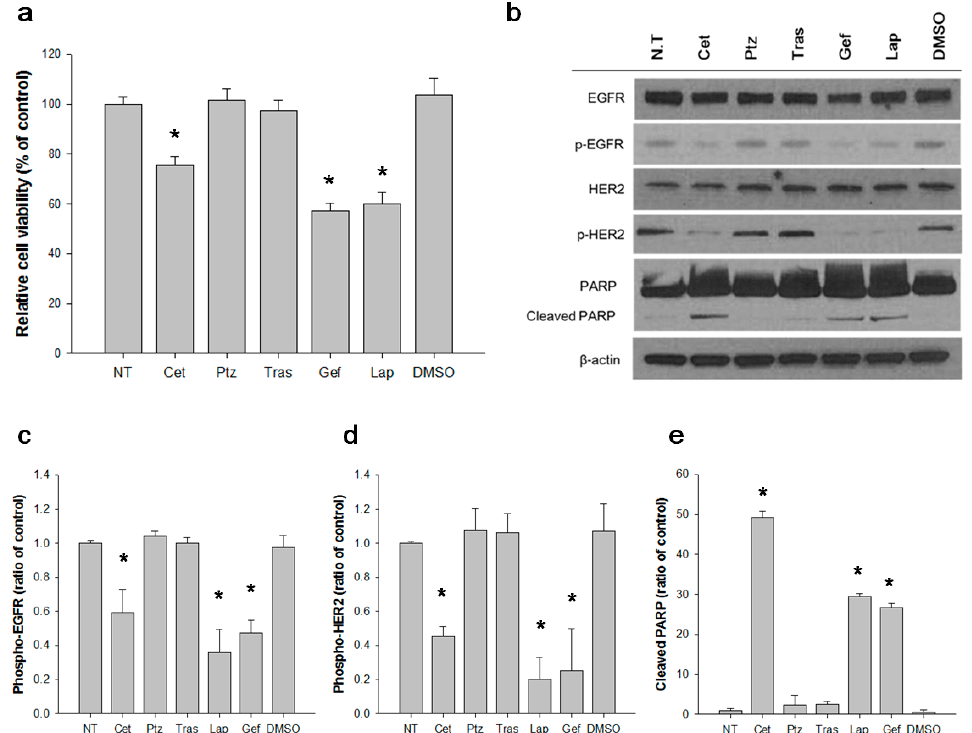
Figure 3. Inhibition of 5637 cell proliferation and receptor activation by anti-HER2 and anti-EGFR agents. Cells were treated with HER2 or EGFR inhibitors for 96 h. ( a ) Cell viability was measured by WST-1 kit as described in materials and methods. Relative cell viability as a percent was determined as ((absorbance in each treatment set—absorbance in untreated set) / absorbance in non-treated set X 100). Results represent the mean ± SD obtained from three independent experiments. * p < 0.05. ( b ) The cell lysate was subjected to immunoblot analysis to visualize the relative phosphorylation level EGFR ( c ) and HER2 ( d ) and the level of cleaved PARP ( e ) Each of these levels were quantified by densitometry and plotted, individually. * p < 0.005. NT; not treated, Cet; Cetuximab, Ptz; Pertuzumab, Gef; Gefitinib, Lap; Lapatinib, DMSO; dimethyl sulfoxide, PARP; poly (ADP-ribose)